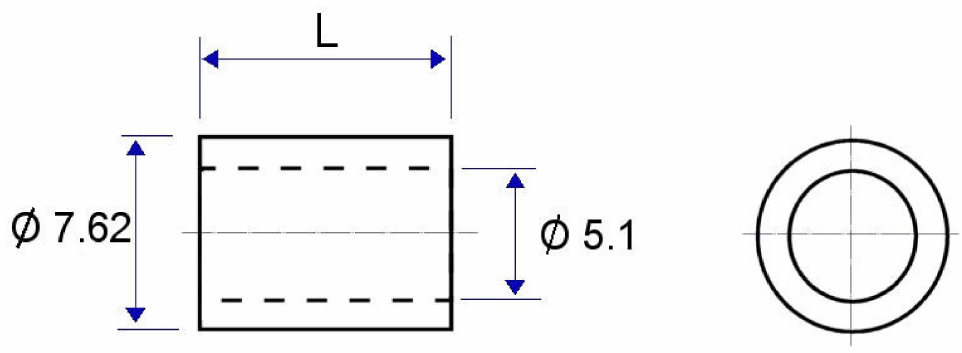
Figure 4. Specimens from each of the two dpa levels were made at either L = 8 mm or 10 mm in length, and checked following specimen preparation for length and straightness of ends.